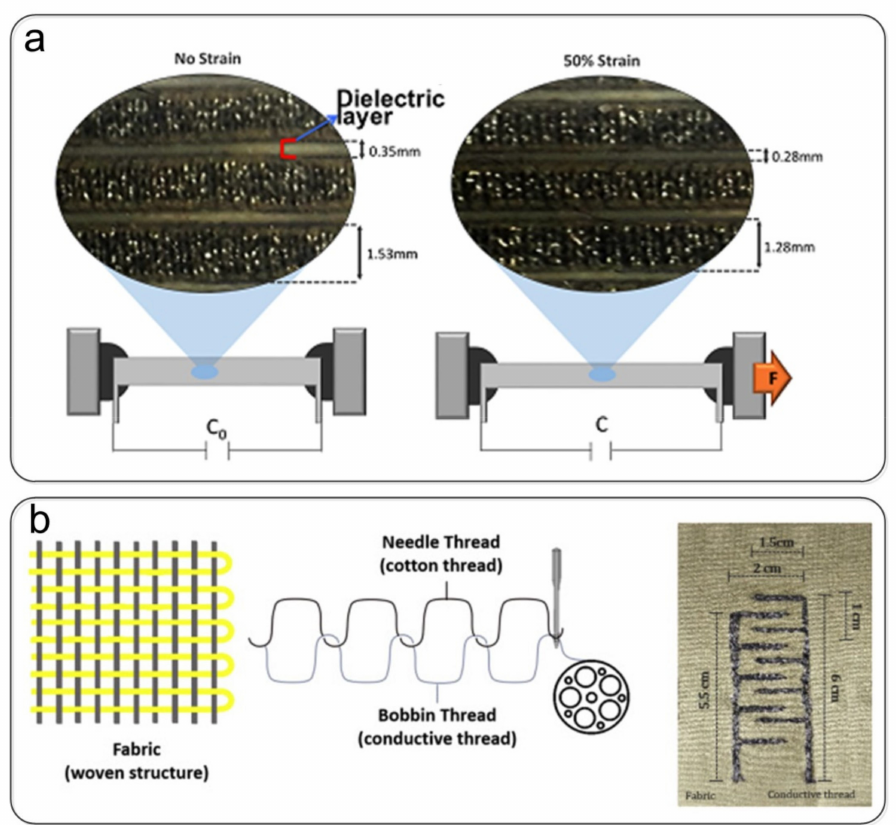
Figure 9. Capacitive pressure sensor based on the in-plane devices. ( a ) Interdigital capacitive strain sensor combining conductive braided fabric and a silicone elastomer. Reproduced with permission from Ref. [137]. Copyright 2021 MDPI. ( b ) Interdigitated capacitor on fabric as a tactile sensor. Reproduced with permission from Ref. [138]. Copyright 2021